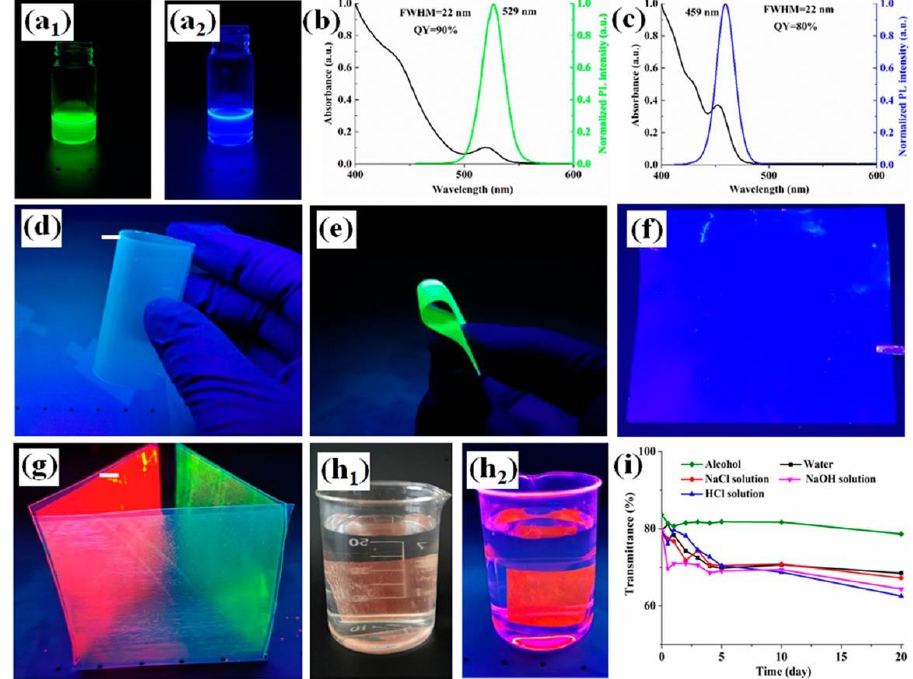
Figure 13. ( a 1 , a 2 ) Luminescence of green and blue QD. ( b , c ) Absorption and photoluminescence spectra of the green and blue QD solutions. ( d – f ) Digital image of a transparent wood film and QD/superthin transparent wood film irradiated by UV light and exhibiting green and blue emission (QD concentration: 0.50 mg/mL). ( g ) Demonstration of light-emitting material using QD/superthin transparent wood films. ( h 1 , h 2 ) Digital image of red QD/superthin transparent wood film immersed in water. ( i ) Transmittance of red QD/superthin transparent wood film immersed in harsh environment. Reprinted with permission from [37], copyright 2022, American Chemical Society.